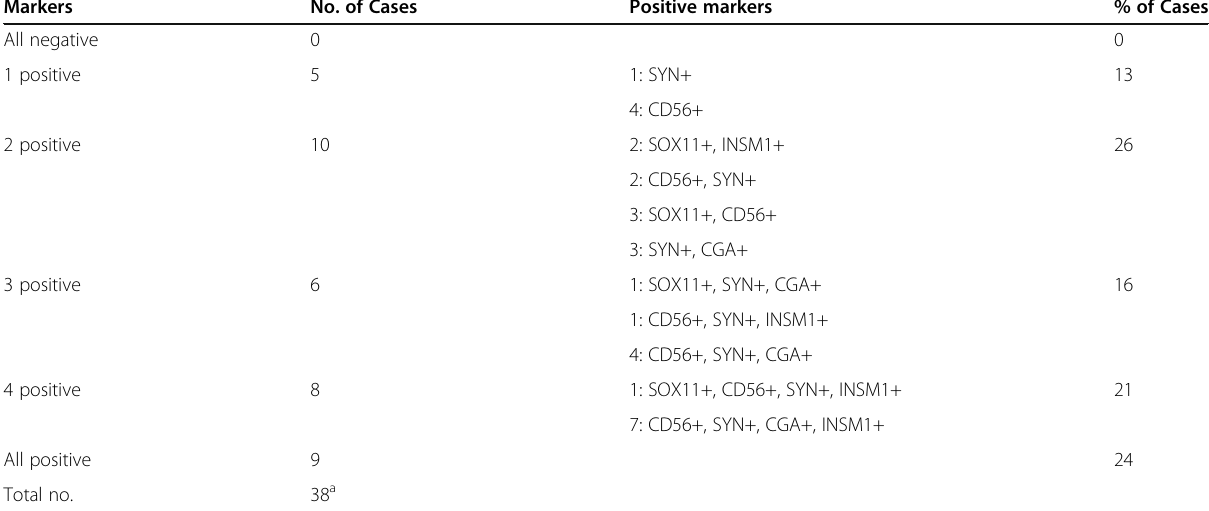
Table 4 Immunoreactivity for Neuroendocrine Markers in LCNEC update Markers